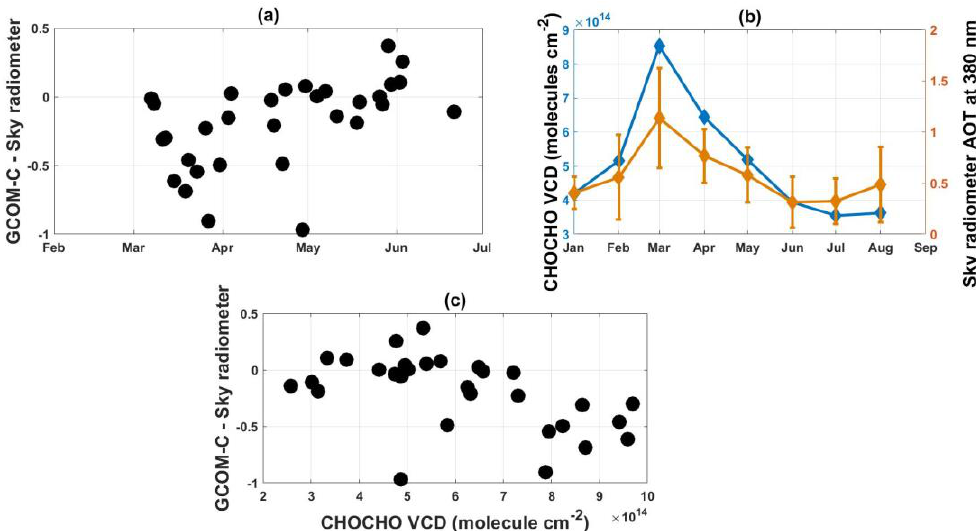
Figure 7. (top panel) ( a ) The time series of the difference between the GCOM-C and sky radiometer AOT at 380 nm in Phimai. ( b ) The seasonal variation of the glyoxal (CHOCHO) vertical column density (VCD)and the sky radiometer AOT values at 380 nm. The CHOCHO VCDs were retrieved from the MAX-DOAS observations using the JM2 algorithm. The error bars show the 1σ standard deviation of the mean values. (bottom panel) ( c ) The difference between coincidence GCOM-C and sky radiometer at 380 nm plotted as a function of CHOCHO VCD values. CHOCHO VCD values for the day prior to the coincident date between MAX-DOAS, sky radiometer, and GCOM-C were plotted.